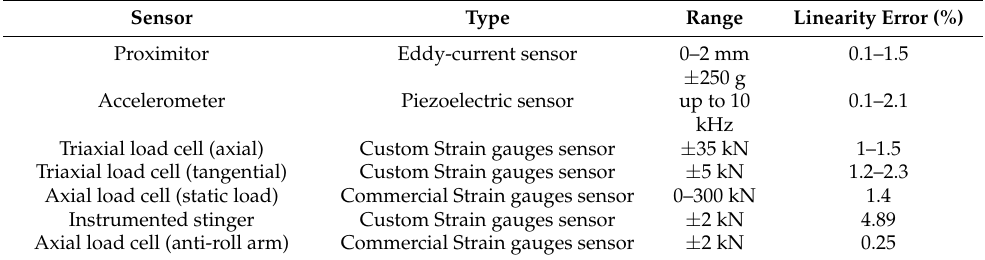
Figure 4. Section of the test apparatus on a plane containing the bearing axis. Eight high-resolution proximity sensors are used to measure the radial relative dis- ular to the bearing axis. Four accelerometers measure the acceleration of the bearing hous- ing at the mid-section (Figure 3). More information about all the sensors used for the dy- namic characterization of the bearing is given in Table 2. Table 2. Measurement range and linearity error for all dynamic sensors. The values of linearity error are the minimum and maximum ones of the installed units for that type of sensor.